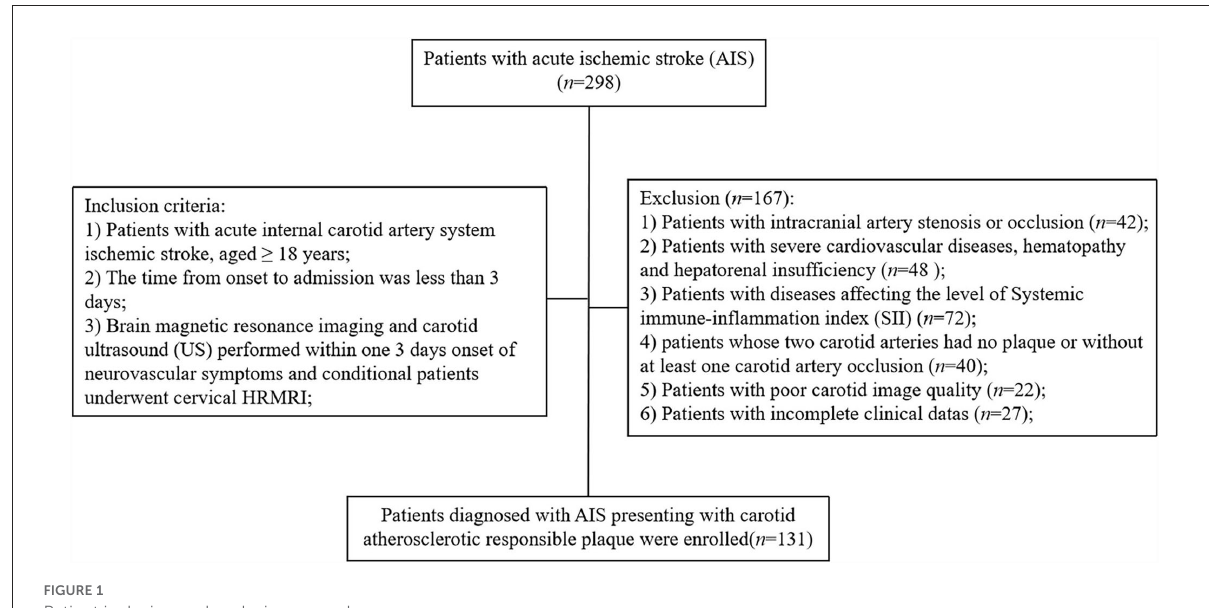
FIGURE1 Patient inclusion and exclusion procedures.